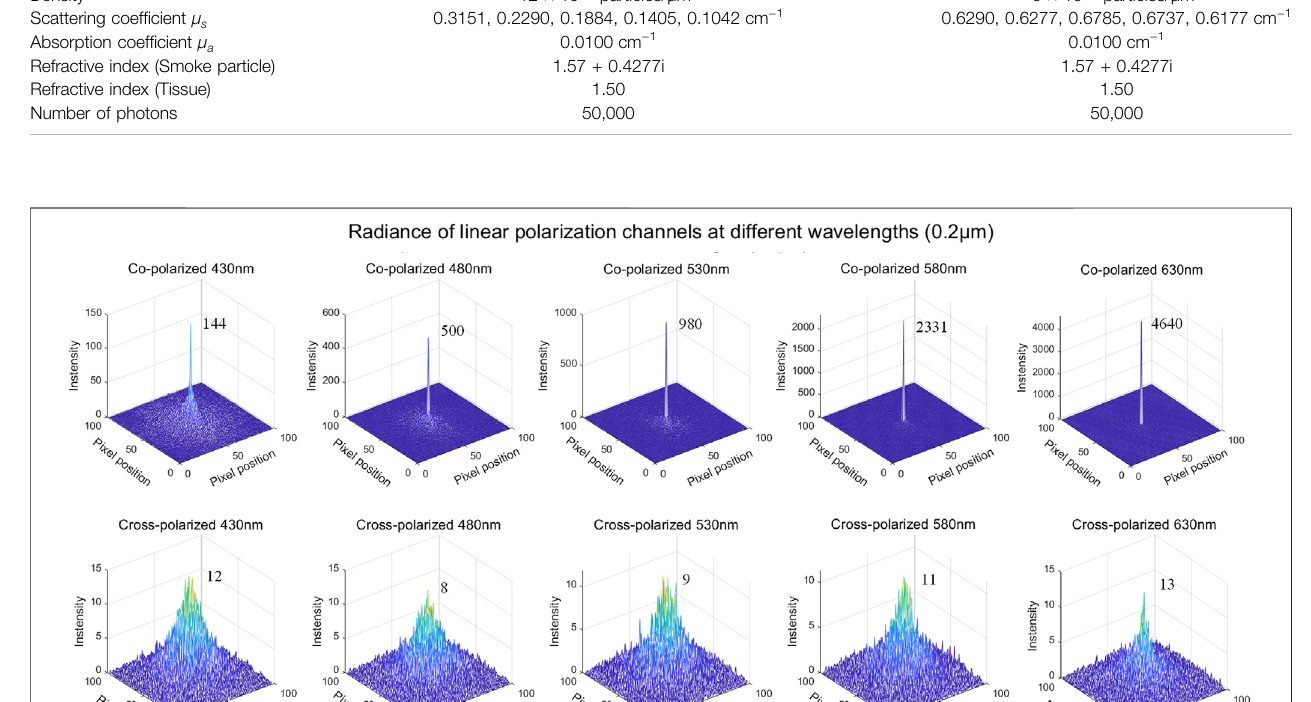
Frontiers in Physics |